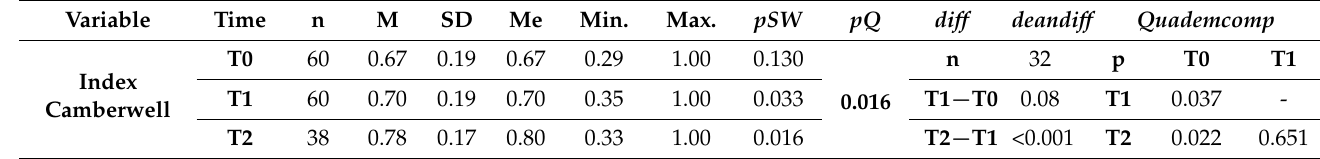
Table 5. The level of satisfaction of needs in the G4 control group at the time T0, T1, T2.